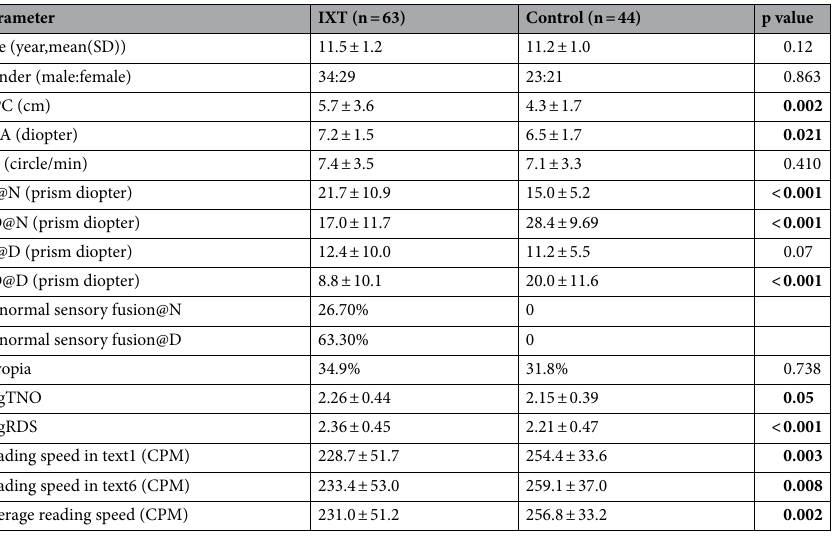
Table 1. Clinical characteristics of 107 subjects. NPC near point of convergence, PRA positive relative accommodative, AF accommodative facility, BI@N base in prism power for fusional vergence amplitudes at near, BO@N base out prism power for fusional vergence amplitudes at near, BI@D base in prism power for fusional vergence amplitudes at distance, BO@D base out prism power for fusional vergence amplitudes at distance, TNO test for stereoscopic vision, a test for near stereo vision, RDS random dot stereo, a test for distance stereo vision, CPM character per minute. Significant values are given in bold. *p < 0.05